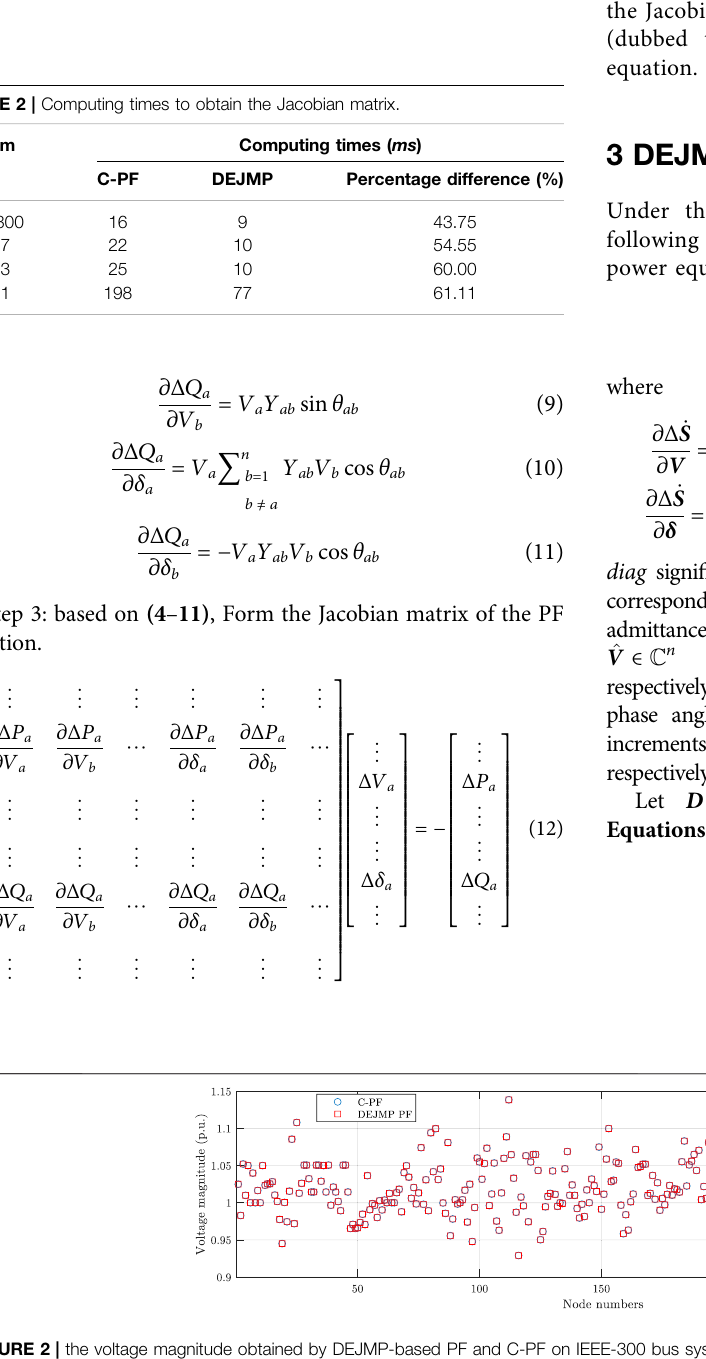
Frontiers in Energy Research |